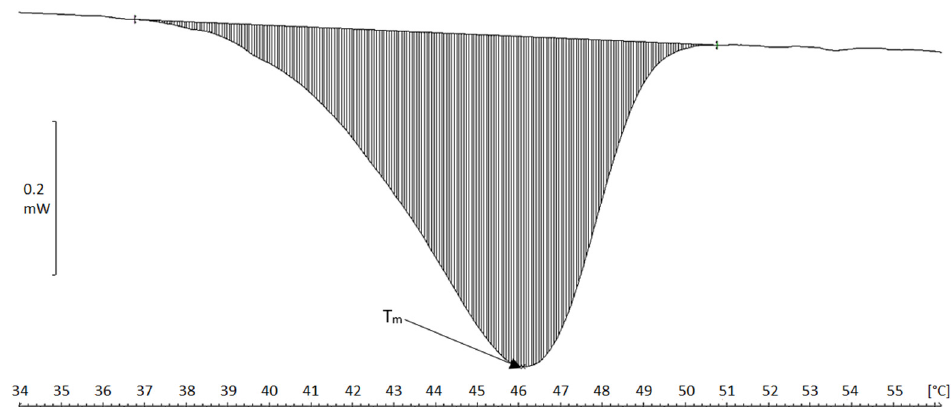
Figure 1. DSC thermogram of atelocollagen fibers in acid solution (obtained after pretreatment of the raw material in NaCl solution).